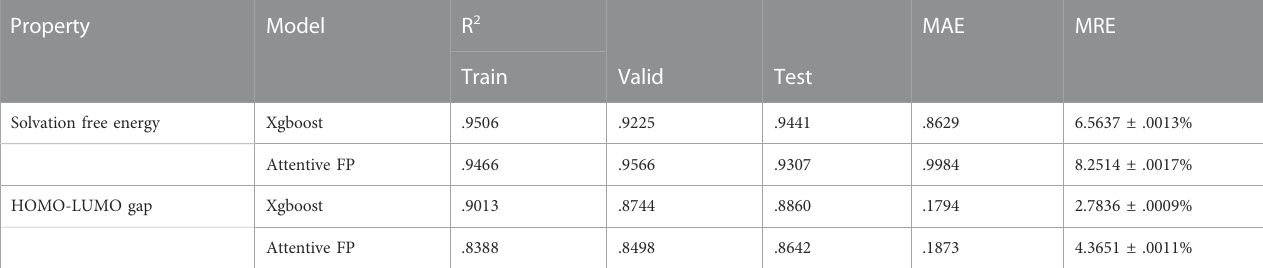
TABLE 1 Various indicators of data fi tting with Xgboost and Attentive FP